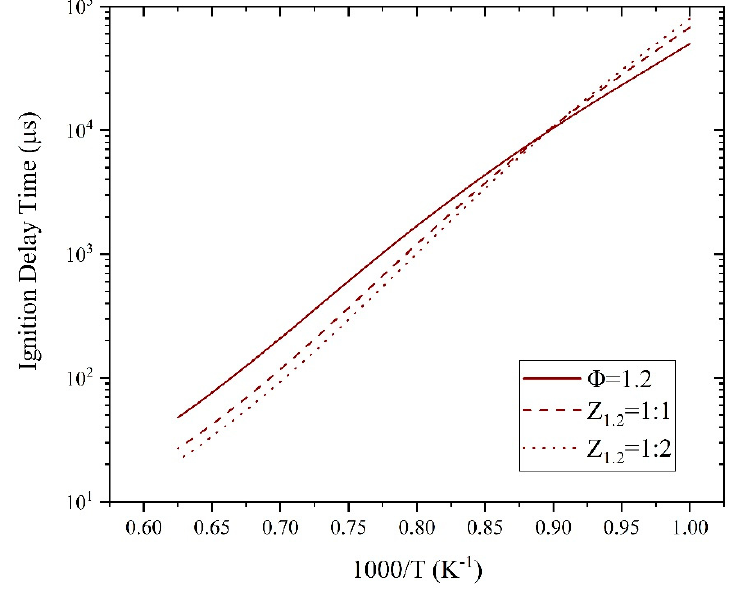
Figure 3. Comparison of the ignition delay times of n -pentane at an equivalence ratio of 1.2 and air–light hydrocarbon mixing gas at mixing degree of 1 and 1/2, respectively.